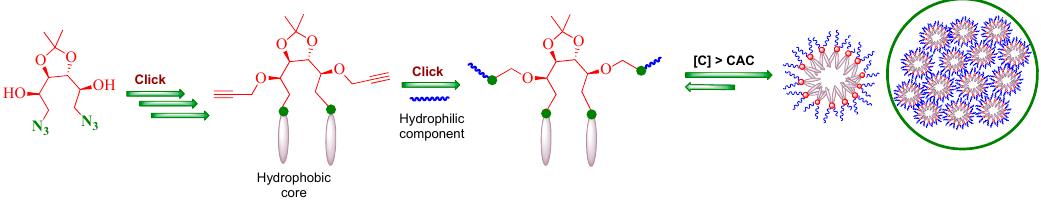
Figure 1. Proposed schematic representation of self-assembly formed by amphiphilic architectures in aqueous solution.